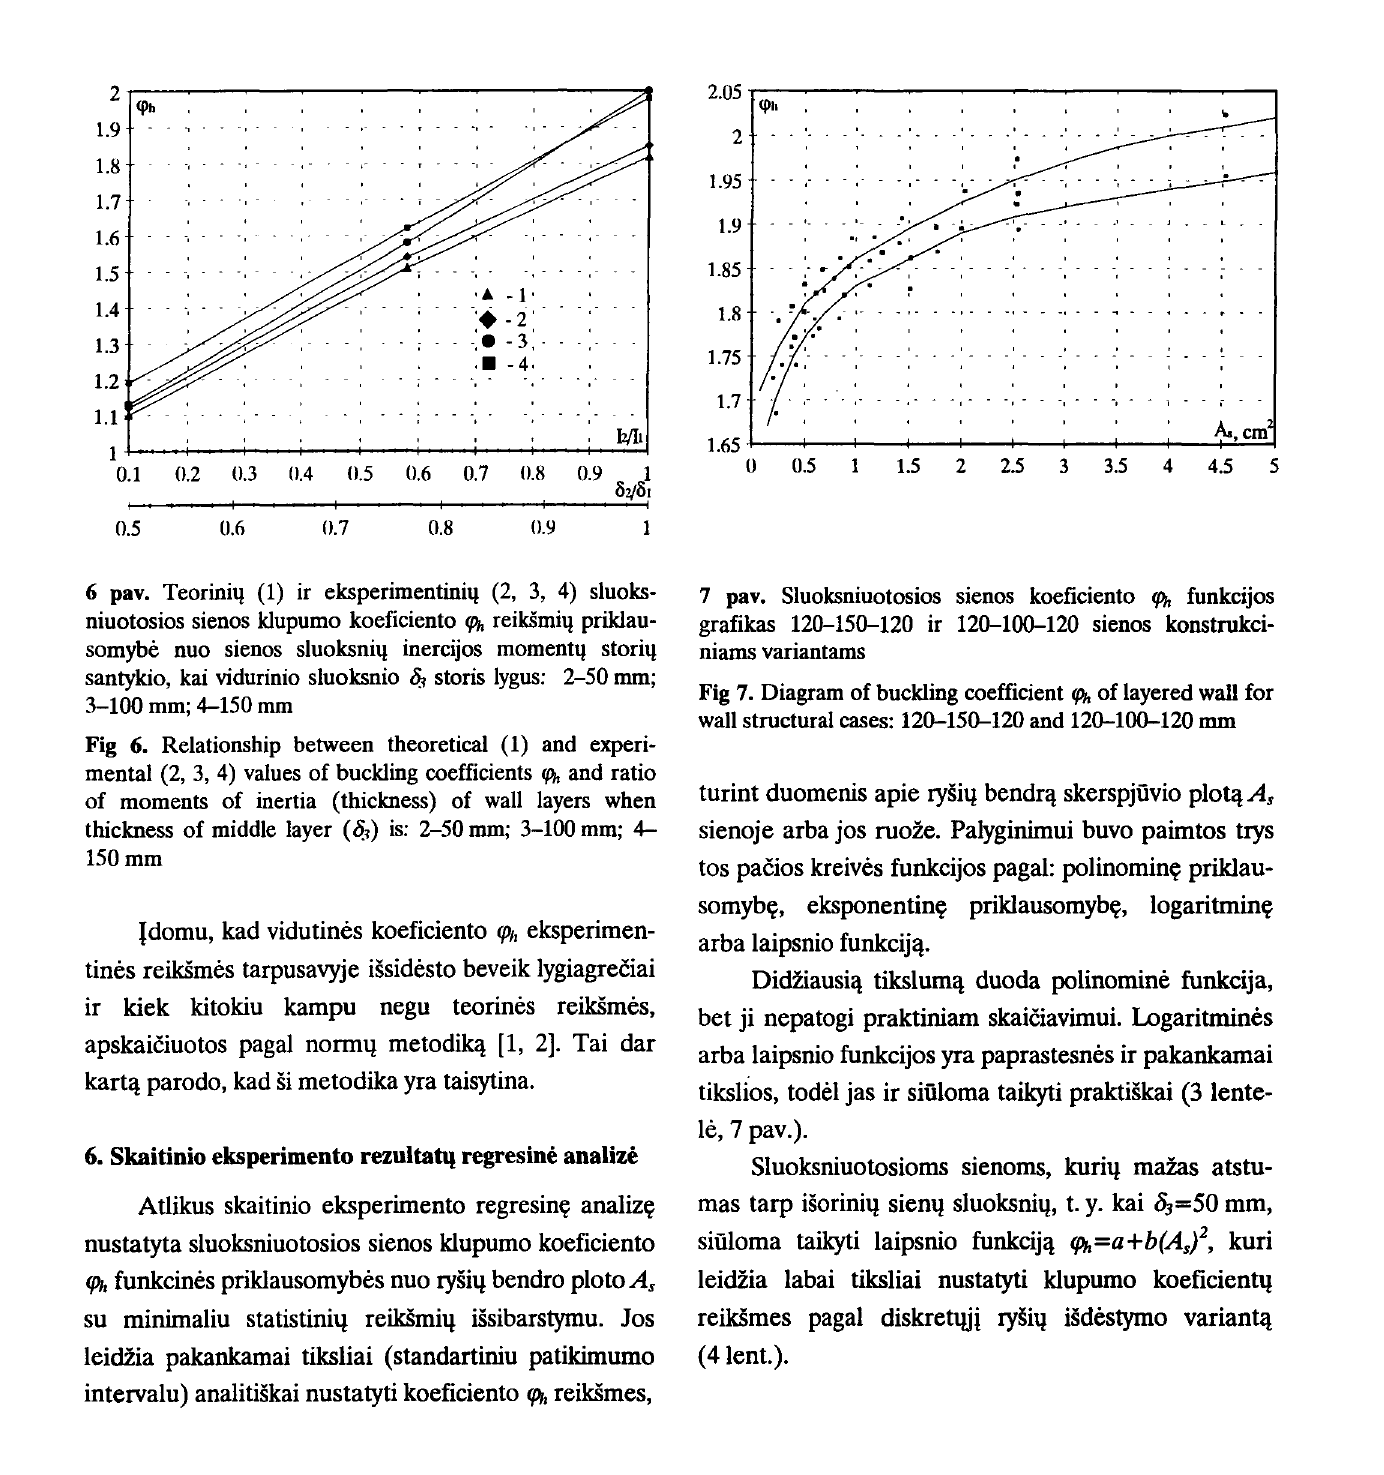
Table 2. Theoretical and experimental values of buckling coefficient rp,.